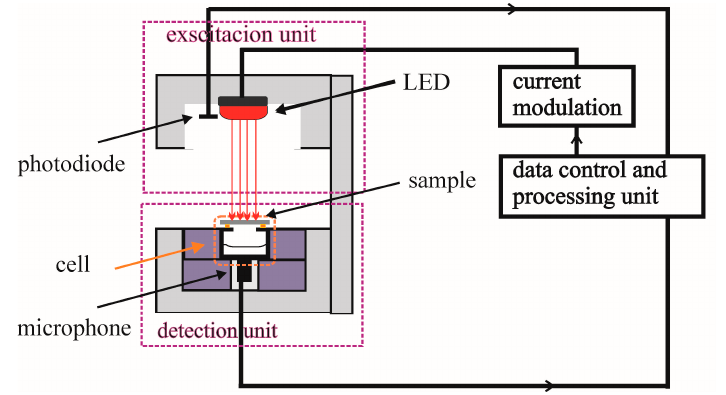
Figure 1. Open-cell experimental set-up in transmission configuration.